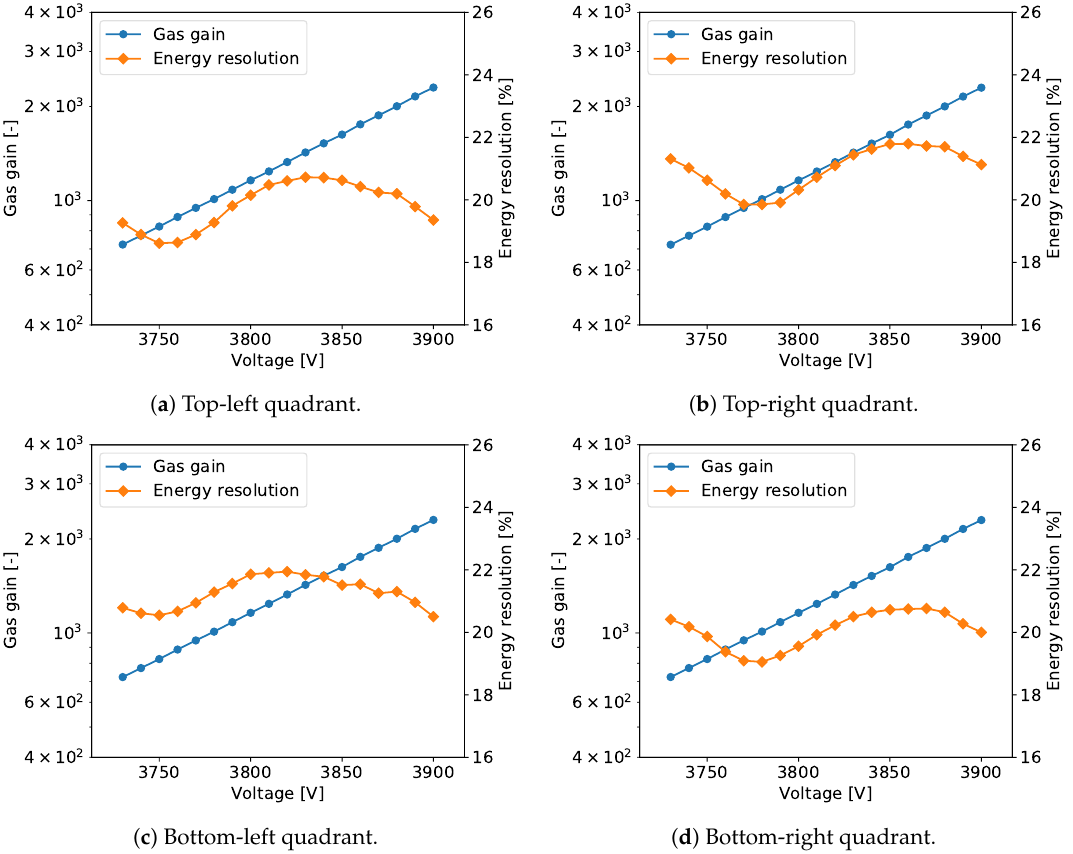
( c ) Bottom-left quadrant. ( d ) Bottom-right quadrant. Figure 17. GEM detector D . Gas gain and energy resolution vs. detector bias voltage for each quadrant of the